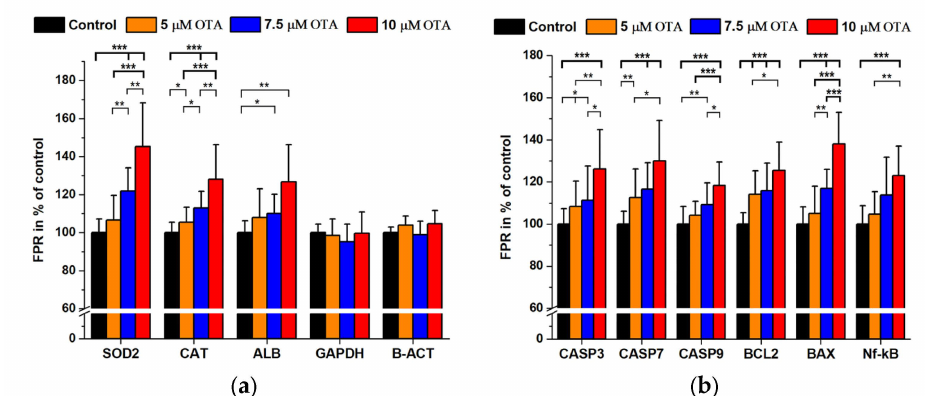
Figure 2. Antioxidant ( a ) and apoptosis-related signal protein expression ( b ) at various OTA concen- trations expressed as FPR % of the controls (N = 6 × 4). *: p < 0.05, **: p < 0.01, ***: p < 0.001.